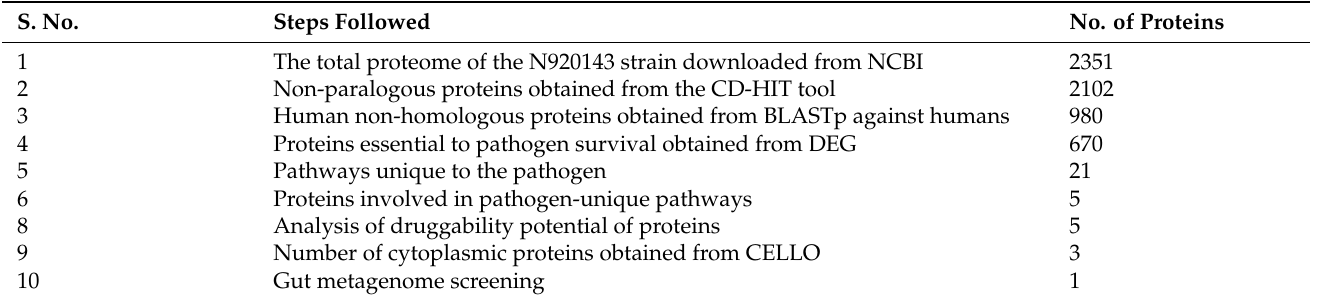
Figure 1. The proposed procedure and methodology followed in the present study. Table 1. The relative number of proteins obtained from each step .